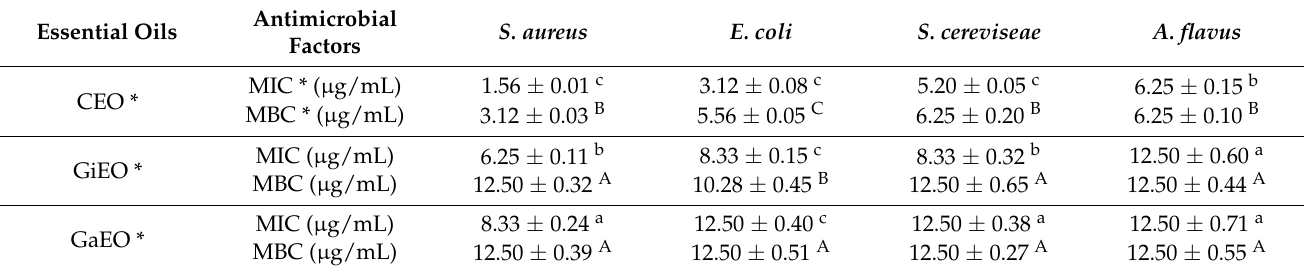
Table 2. The antimicrobial activity of various EOs on selected foodborne microorganisms. Essential